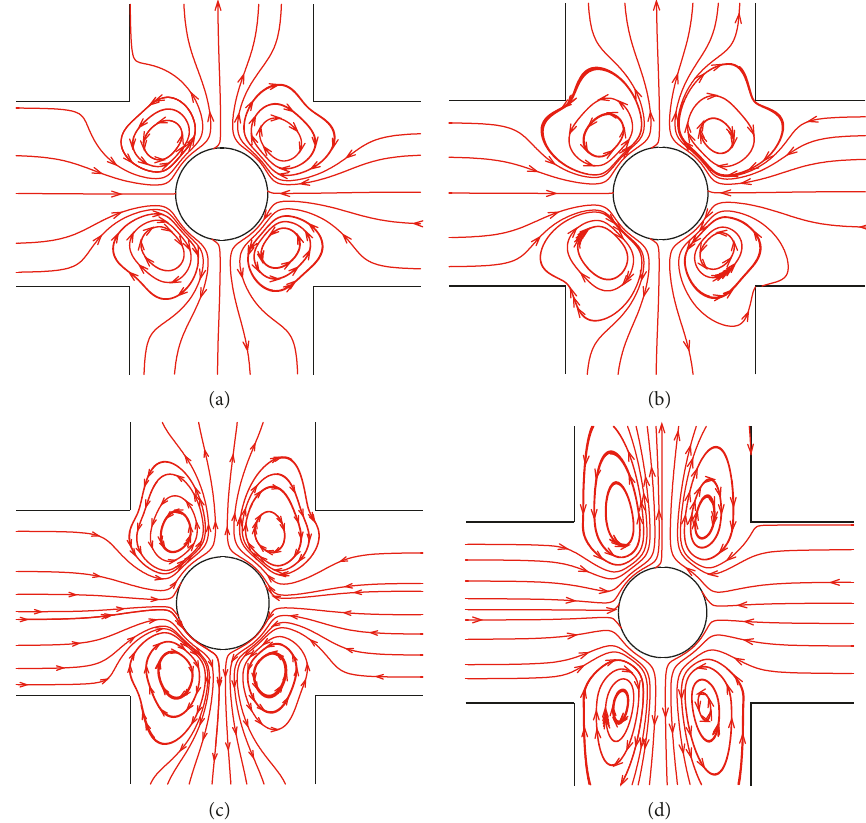
a (cid:31) 10V, (b) φ a (cid:31) 100V, (c) φ a (cid:31) 200V, and (d)